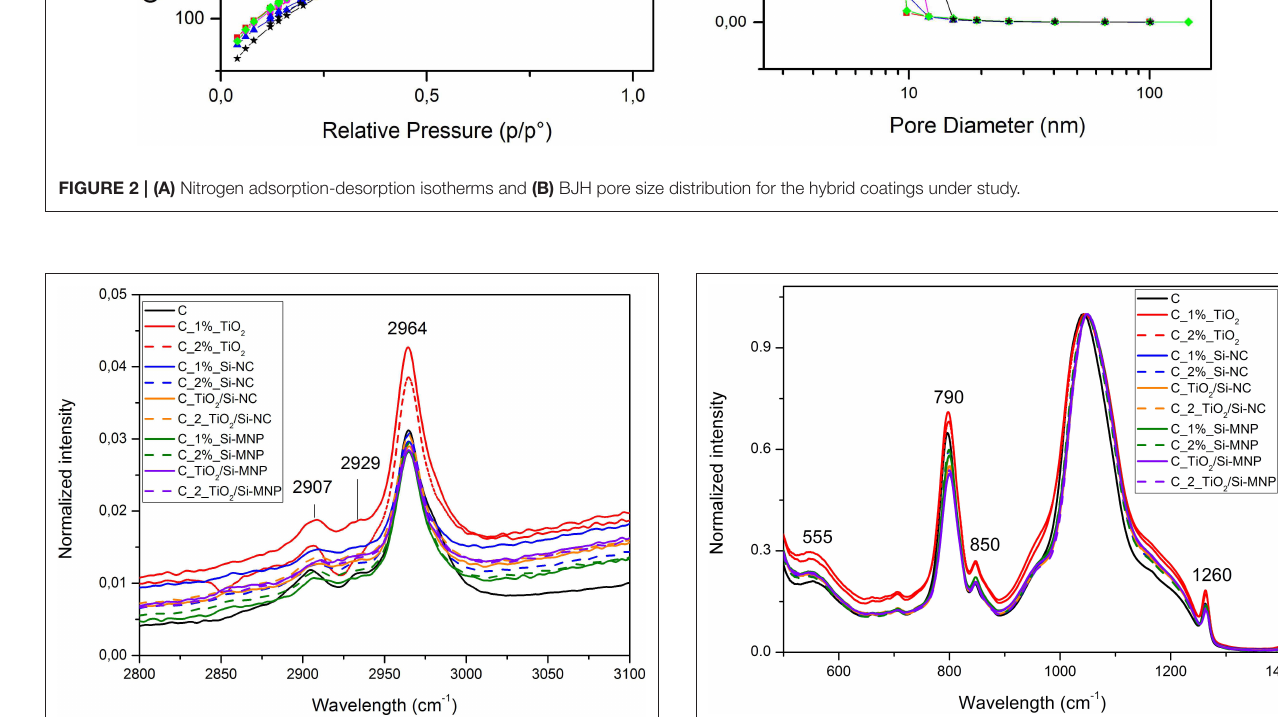
Si-MNP, decreasing the pore diameter of the C_ TiO 2 /Si-MNP (Pinho and Mosquera, 2011).